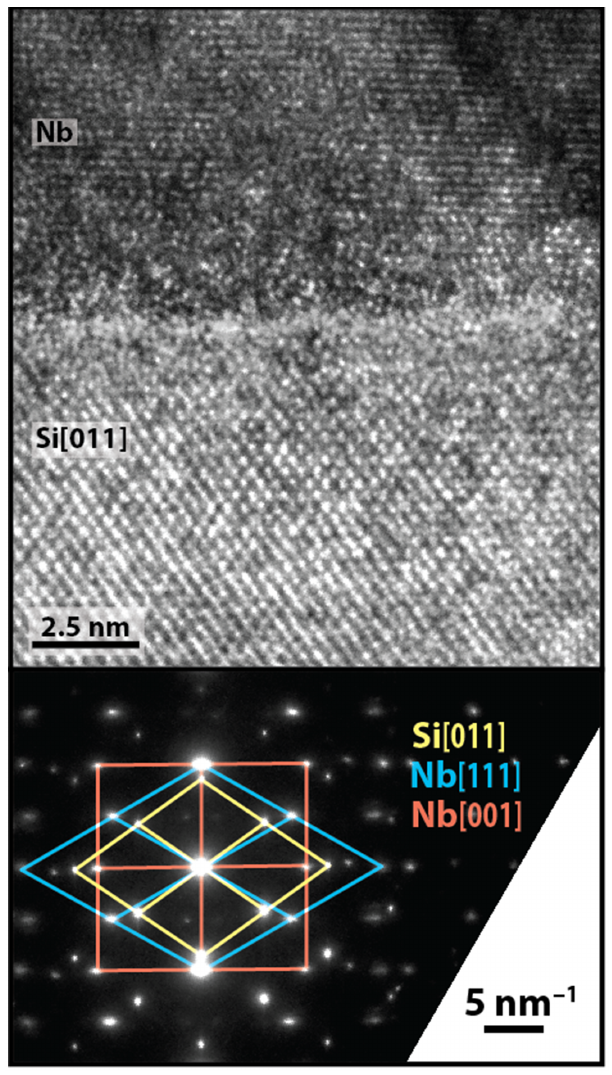
FIG. 10. The niobium-silicon metal-substrate (MS) interface. (a) A high-resolution TEM image shows a clean Nb-Si interface with little to no amorphization and apparent expitaxial niobium- grain nucleation. (b) TEM nanobeam diffraction from a larger region confirms the preferred orientations of Nb grains on Si. Two different Nb grain orientations are observed (see